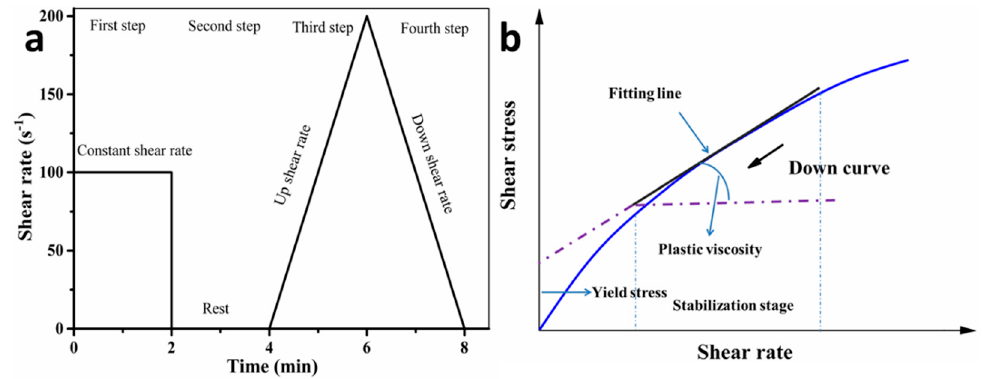
Figure 3. ( a ) The test program of rheology and ( b ) The fitting line of plastic viscosity and yield stress was obtained by the calculation of Bingham model based on the down curve of shear stress